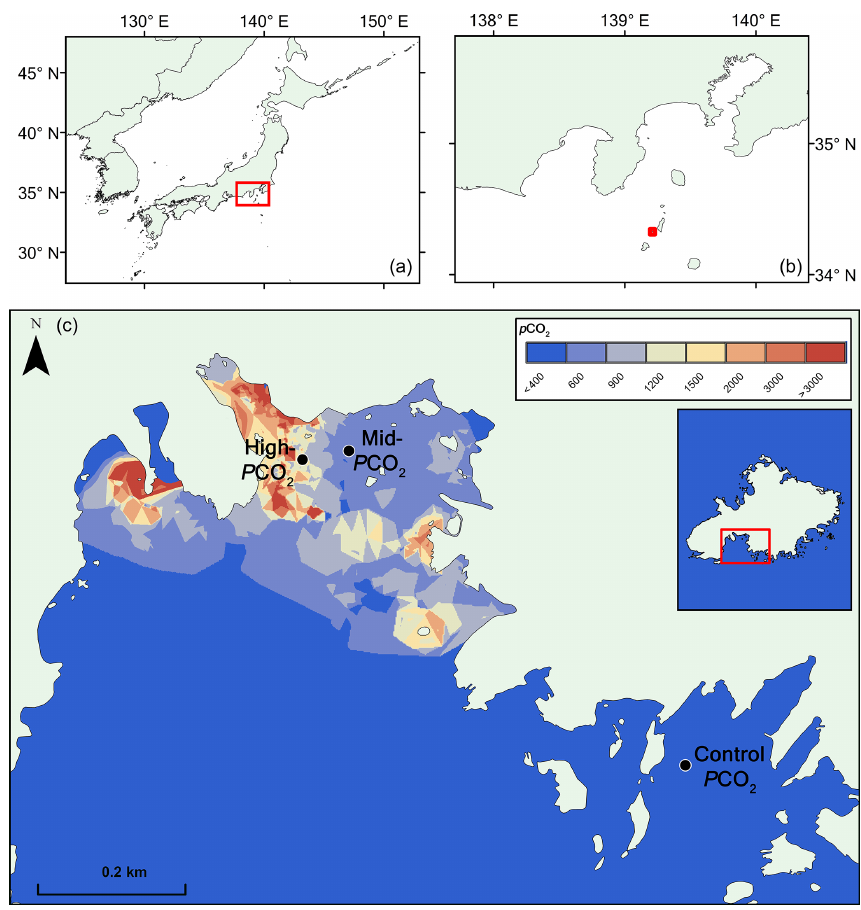
Figure 1. Map of p CO 2 in the study region at Shikine Island (Japan). Panels (a, b) show the geographical context. Panel (c) shows the bay on Shikine Island, with spatial variability in p CO 2 (Agostini et al., 2018), computed using the nearest neighbor algorithm in ArcGIS 10.2 software (http://www.esri.com/software/arcgis/, last access: 1 November